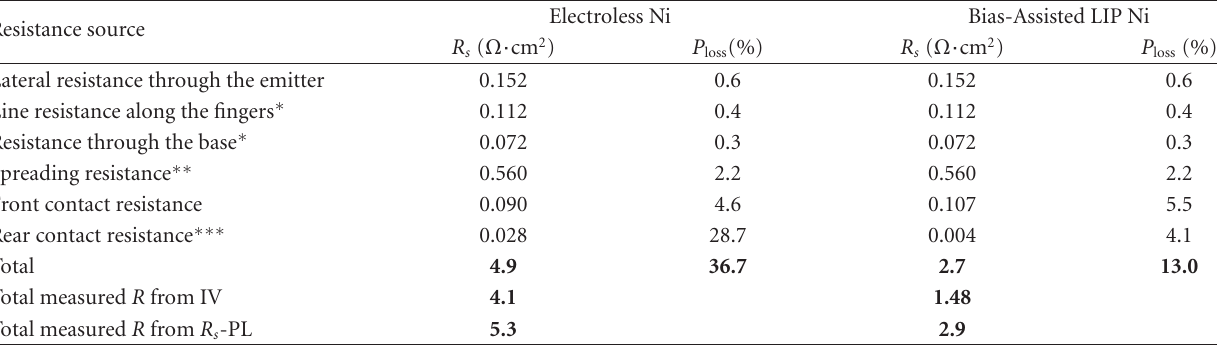
Table 4: Sources of series resistance.